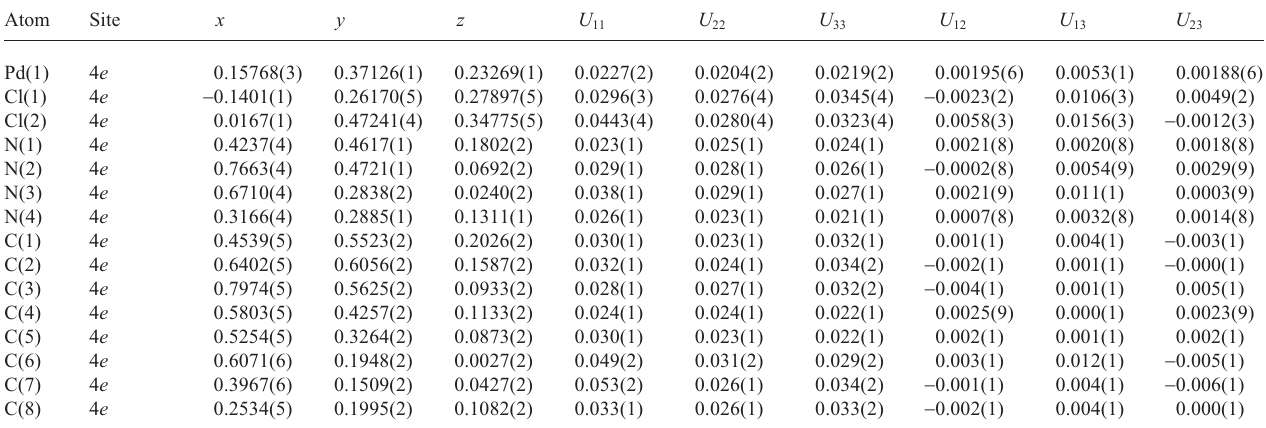
Table 3. Atomic coordinates and displacement parameters (in Å 2 )